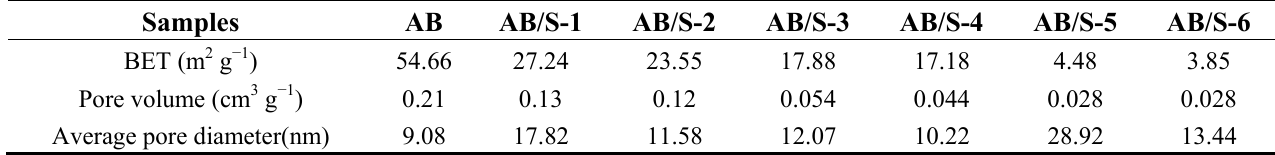
Table 2. BET specific surface area, pore volume and average pore diameter of AB and AB/S.